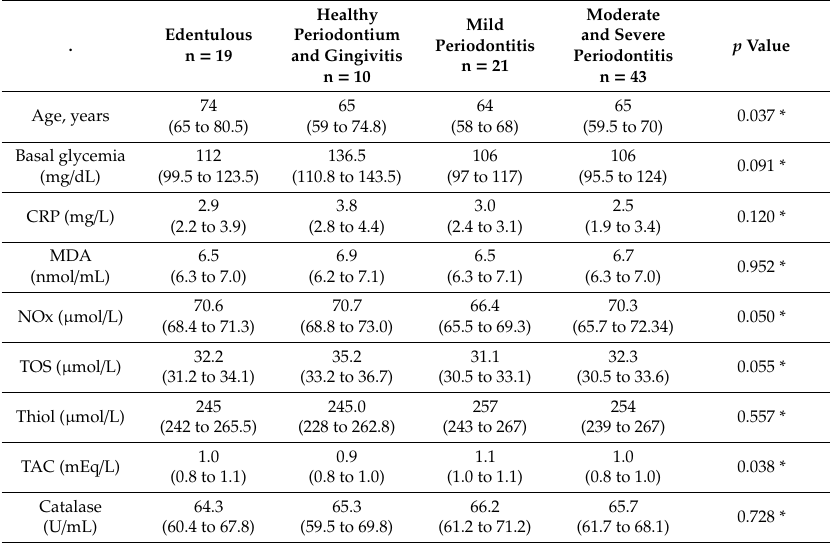
Table 3. Di ff erences among the periodontal disease